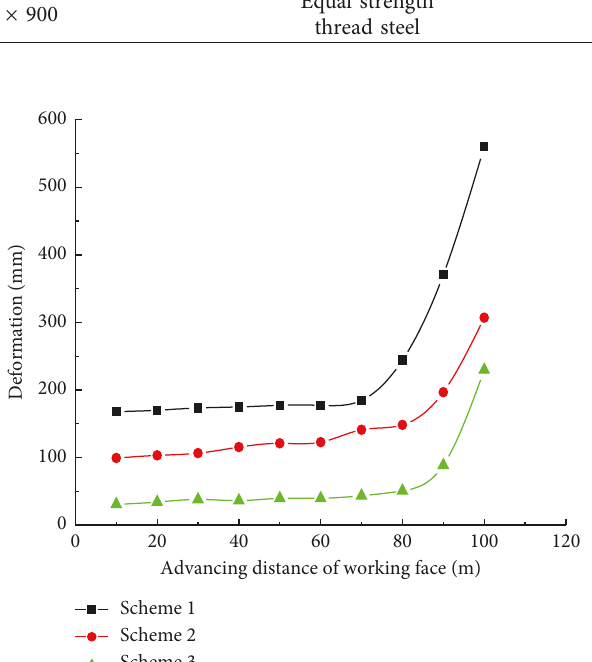
Figure 7: Assistant retracement channel: major wall deformation.